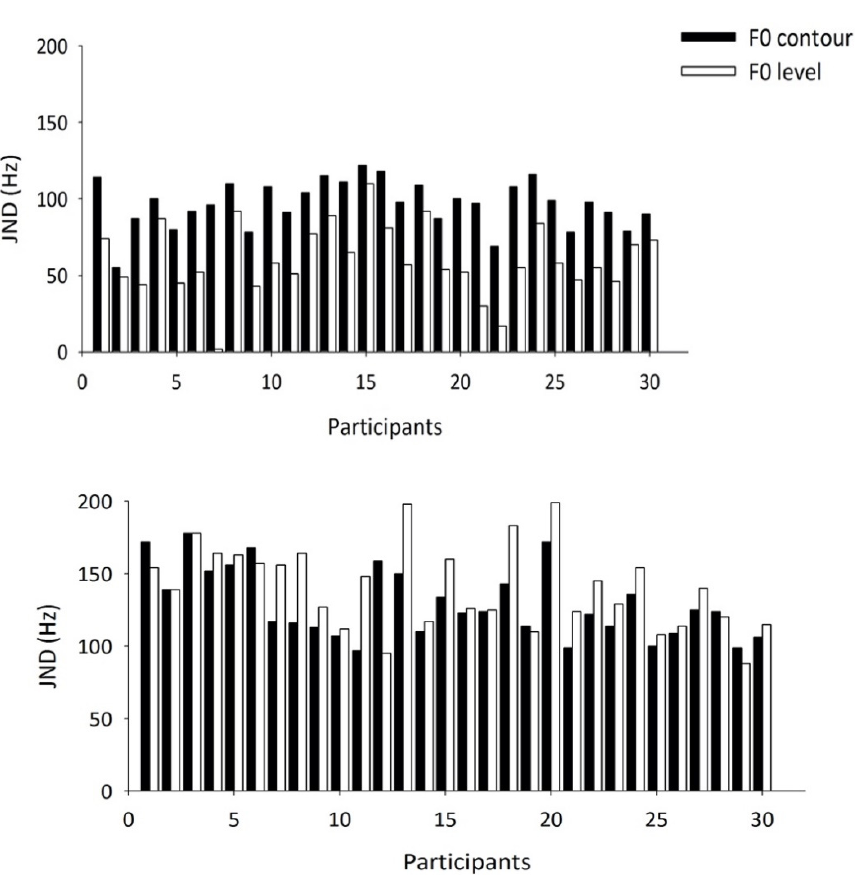
Figure 3. JNDs of F0 contour change and F0 level change in the 30 children with normal hearing ( upper panel ) and in the 30 children with CIs ( lower panel ). Table 2. Percentage of the children with CIs exhibiting different patterns of JNDs of F0 level (JND- L) and F0 contour (JND-C) change regarding each type of speech processing strategy.